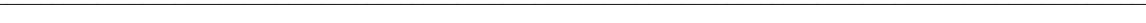
Fig. 3. Psammosteus livonicus Obruchev, specimens from the Amata RS, Upper Devonian. A – H , branchial plates of adult individuals, I – Q , ridge scales of adult individuals . A – D , PIN 1737/8, left branchial plate, Pasta muiža, Latvia; A, dorsal, B, ventral, C, distal and D, anterolateral views. E – H , GIT 116-273, right branchial plate, Pasta muiža, Latvia; E, dorsal, F, ventral, G, posterior and H, distal views. I – K , PIN 1737/9, ventral ridge scale, Pasta muiža, Latvia; I, external, J, visceral and K, lateral views. L – O , PIN 1737/76, ventral ridge scale, Yam-Tesovo, Russia; L, external, M, visceral, N, lateral and O, proximal views. Scale bars: A–H = 2 cm, I–O = 1